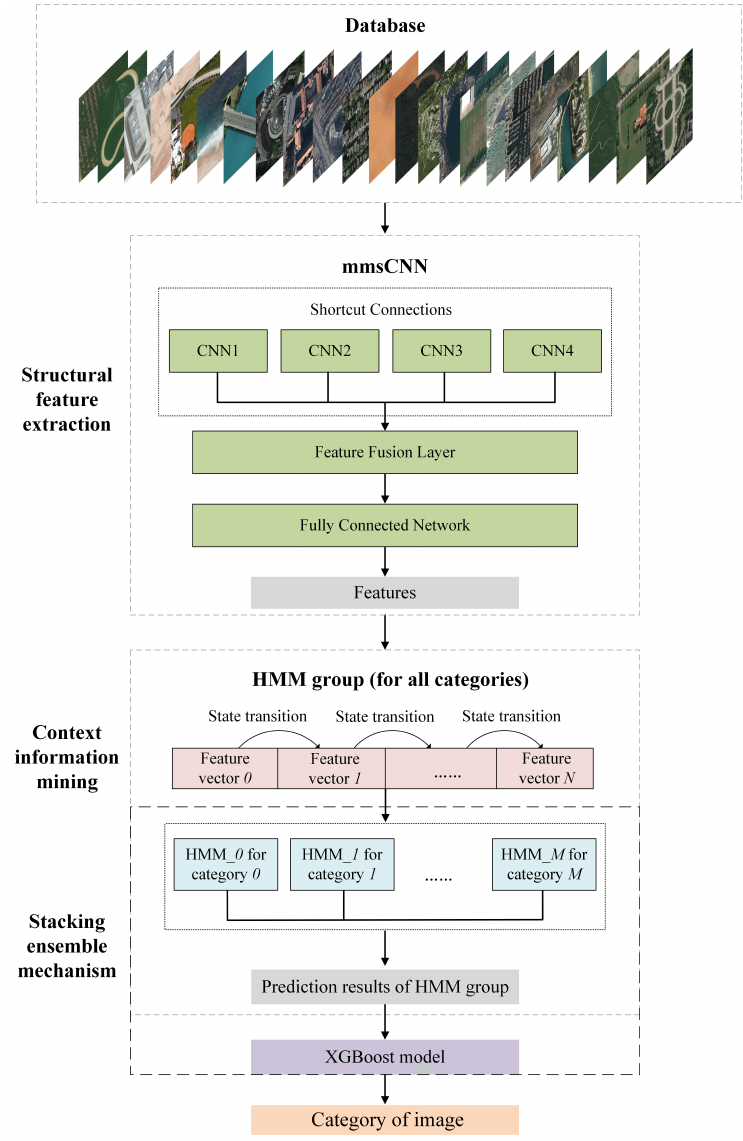
Figure 2. The basic framework of our